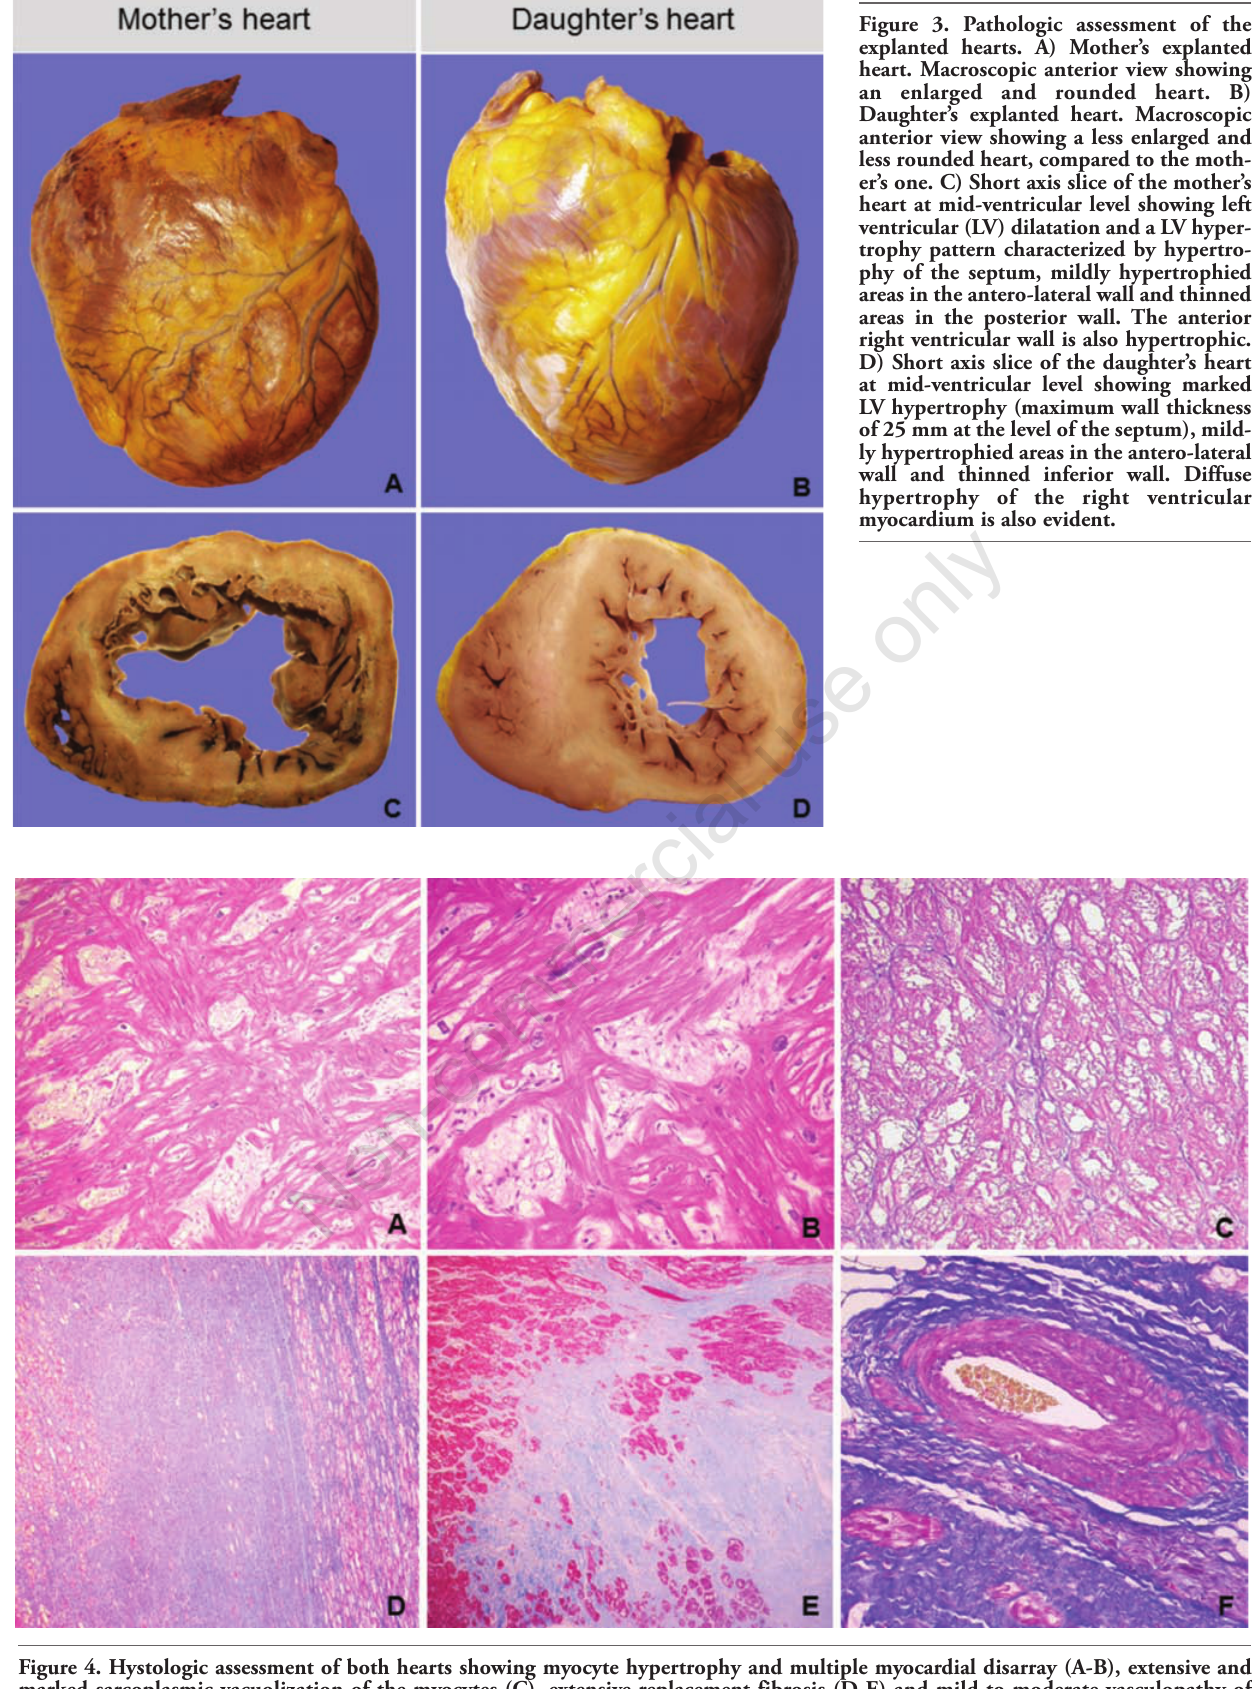
Figure 3. Pathologic assessment of the explanted hearts. A) Mother’s explanted heart. Macroscopic anterior view showing an enlarged and rounded heart. B) Daughter’s explanted heart. Macroscopic anterior view showing a less enlarged and less rounded heart, compared to the moth- er’s one. C) Short axis slice of the mother’s heart at mid-ventricular level showing left ventricular (LV) dilatation and a LV hyper- trophy pattern characterized by hypertro- phy of the septum, mildly hypertrophied areas in the antero-lateral wall and thinned areas in the posterior wall. The anterior right ventricular wall is also hypertrophic. D) Short axis slice of the daughter’s heart at mid-ventricular level showing marked LV hypertrophy (maximum wall thickness of 25 mm at the level of the septum), mild- ly hypertrophied areas in the antero-lateral wall and thinned inferior wall. Diffuse hypertrophy of the right ventricular myocardium is also evident.